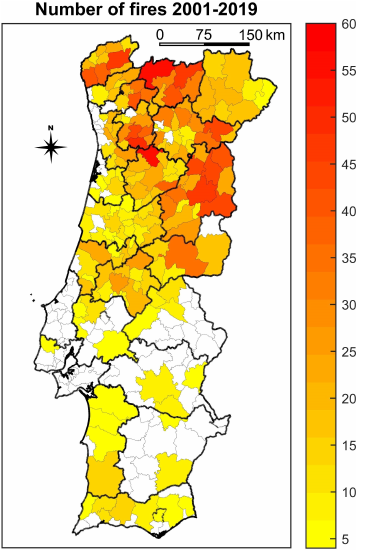
Figure A1. Number of fires larger than 100ha, all during the period 2001–2019, for the selected